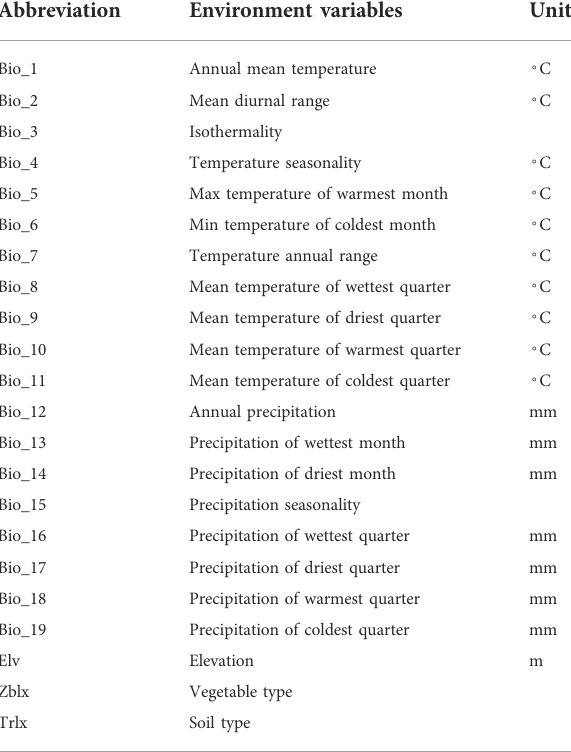
TABLE 1 The environment variables